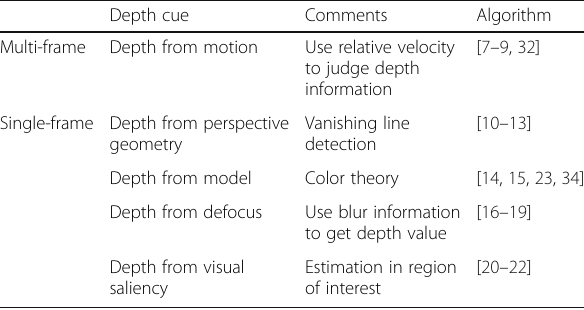
Table 1 The classification of the methods on depth map